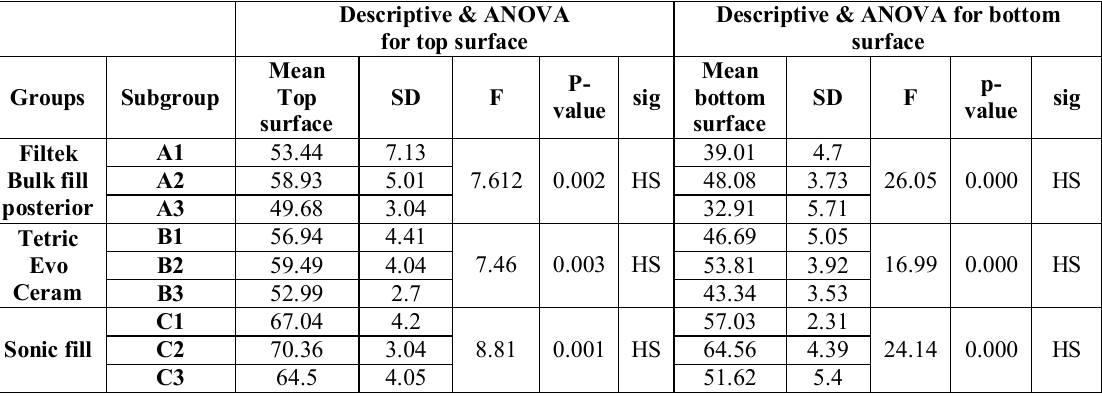
Table 5: Descriptive and interfacial statistics for top and bottom surfaces for the tested materials